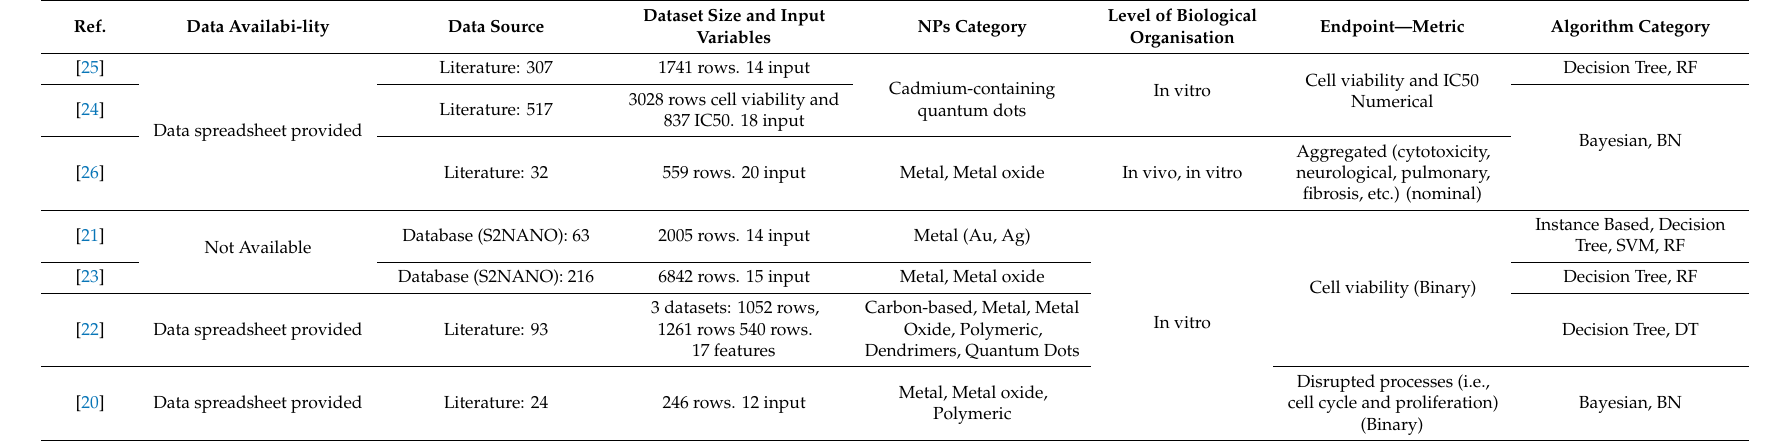
Table 5. In silico tools available in the literature capturing neurotoxicity. Data source and number of studies regarding data compilation, its size for all tissues, level of biological organization, and final input variables used to predict an endpoint. The algorithm implemented is also shown.